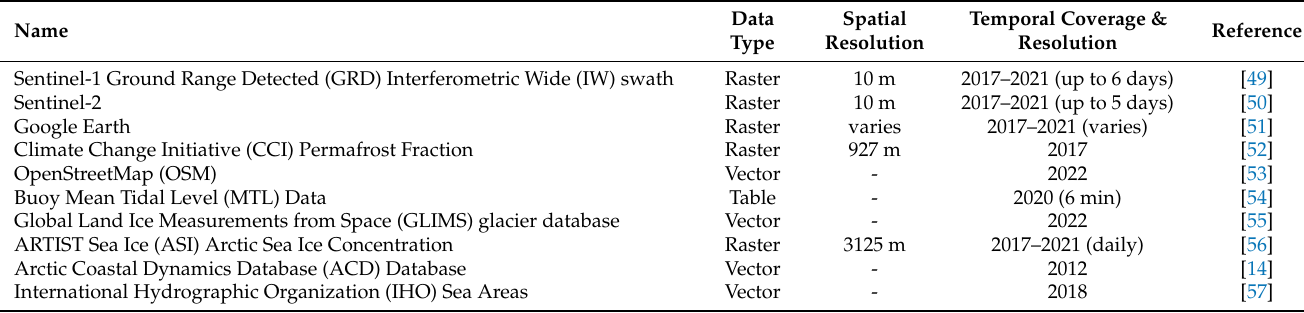
Table 1. List of data utilized within the framework of this study. The column “Temporal Coverage & Resolution” provides information about the temporal window of used data in this study, as well as the frequency of available data within this time span in